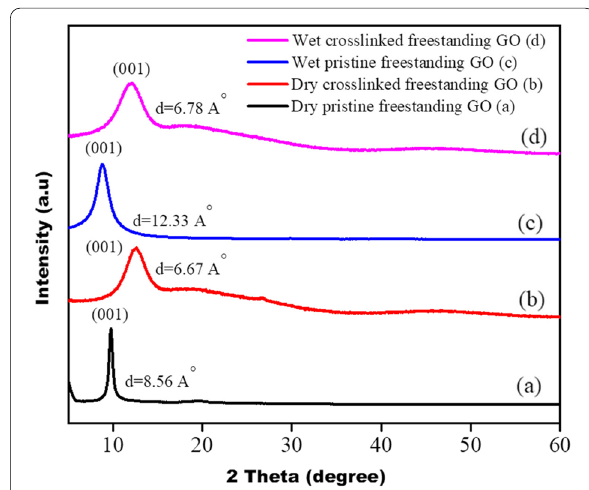
Fig. 5 XRD pattern of freestanding GO membrane and chemically crosslinked freestanding GO membrane in dry and wet conditions